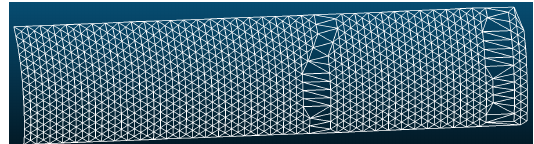
Figure 4. Triangle mesh of the 3D points.